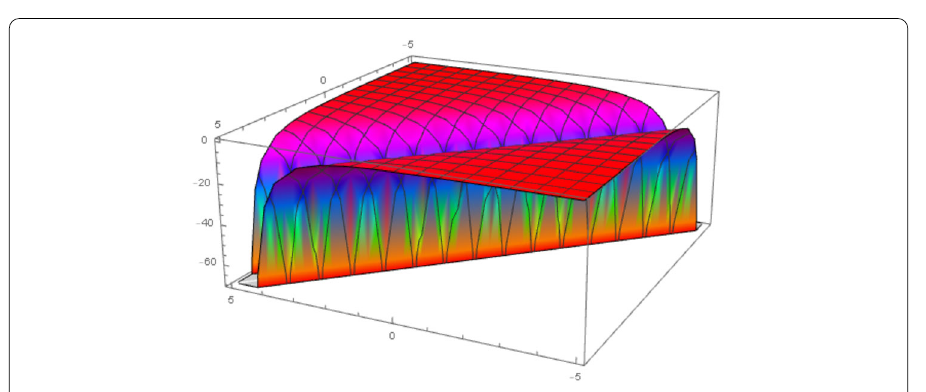
Figure 3 Solitary wave solution u 2 ( η ) for α = 0.30, a 1 = 11, λ = 1, V = 12, b 1 = 11, μ = 3